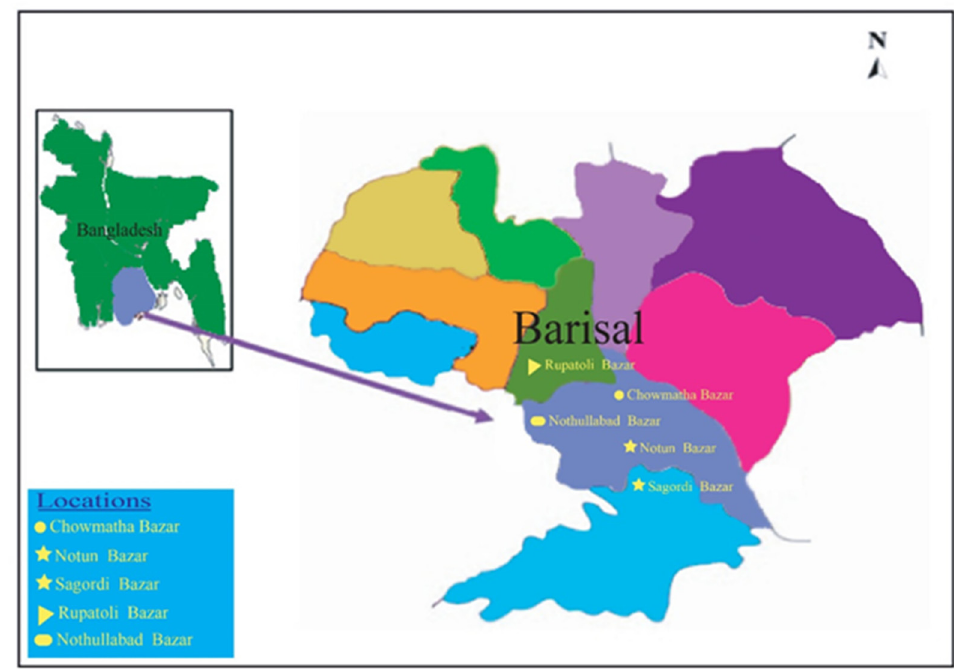
Figure 1. Map showing different sampling locations in the Barishal district, Bangladesh.